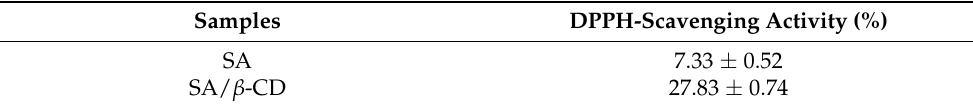
Table 1. Antioxidant activity of SA and SA/ β -CD.